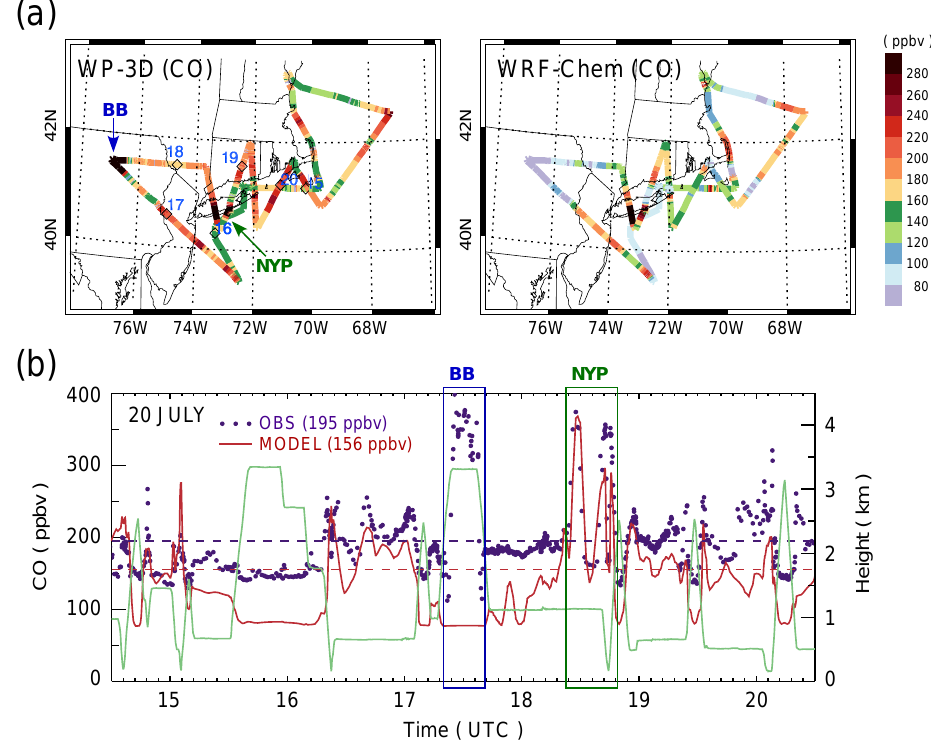
Fig. 4. (a) Observed and simulated CO mixing ratios along the WP-3D flight track on 20 July. Times of aircraft measurement are depicted. (b) Comparison of observed (dot) and simulated (red line) CO mixing ratios on 20 July as a function of time. “NYP” and “BB” in the figures indicate New York City urban plumes and biomass-burning plumes. Green solid line denotes the aircraft altitude. Dashed lines and values in (b) indicate mean mixing ratios below 1.5km in observation and simulation,